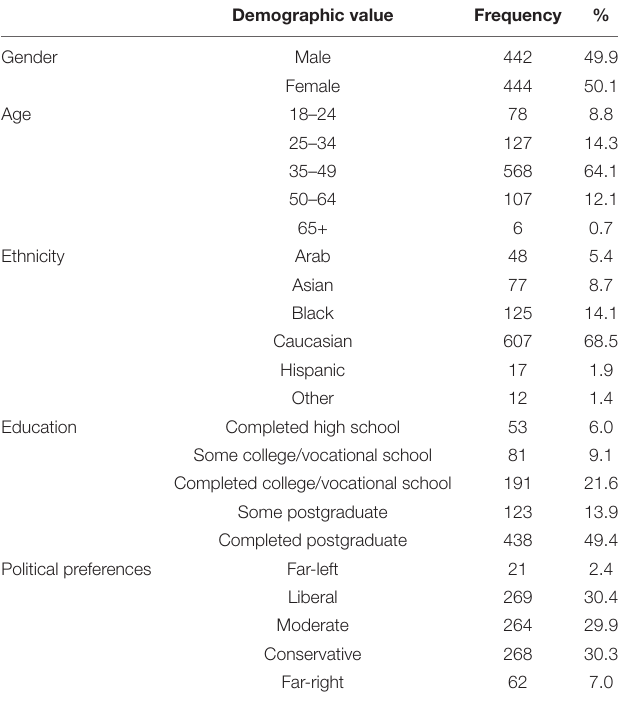
TABLE 1 | Demographic profile distribution ( N =